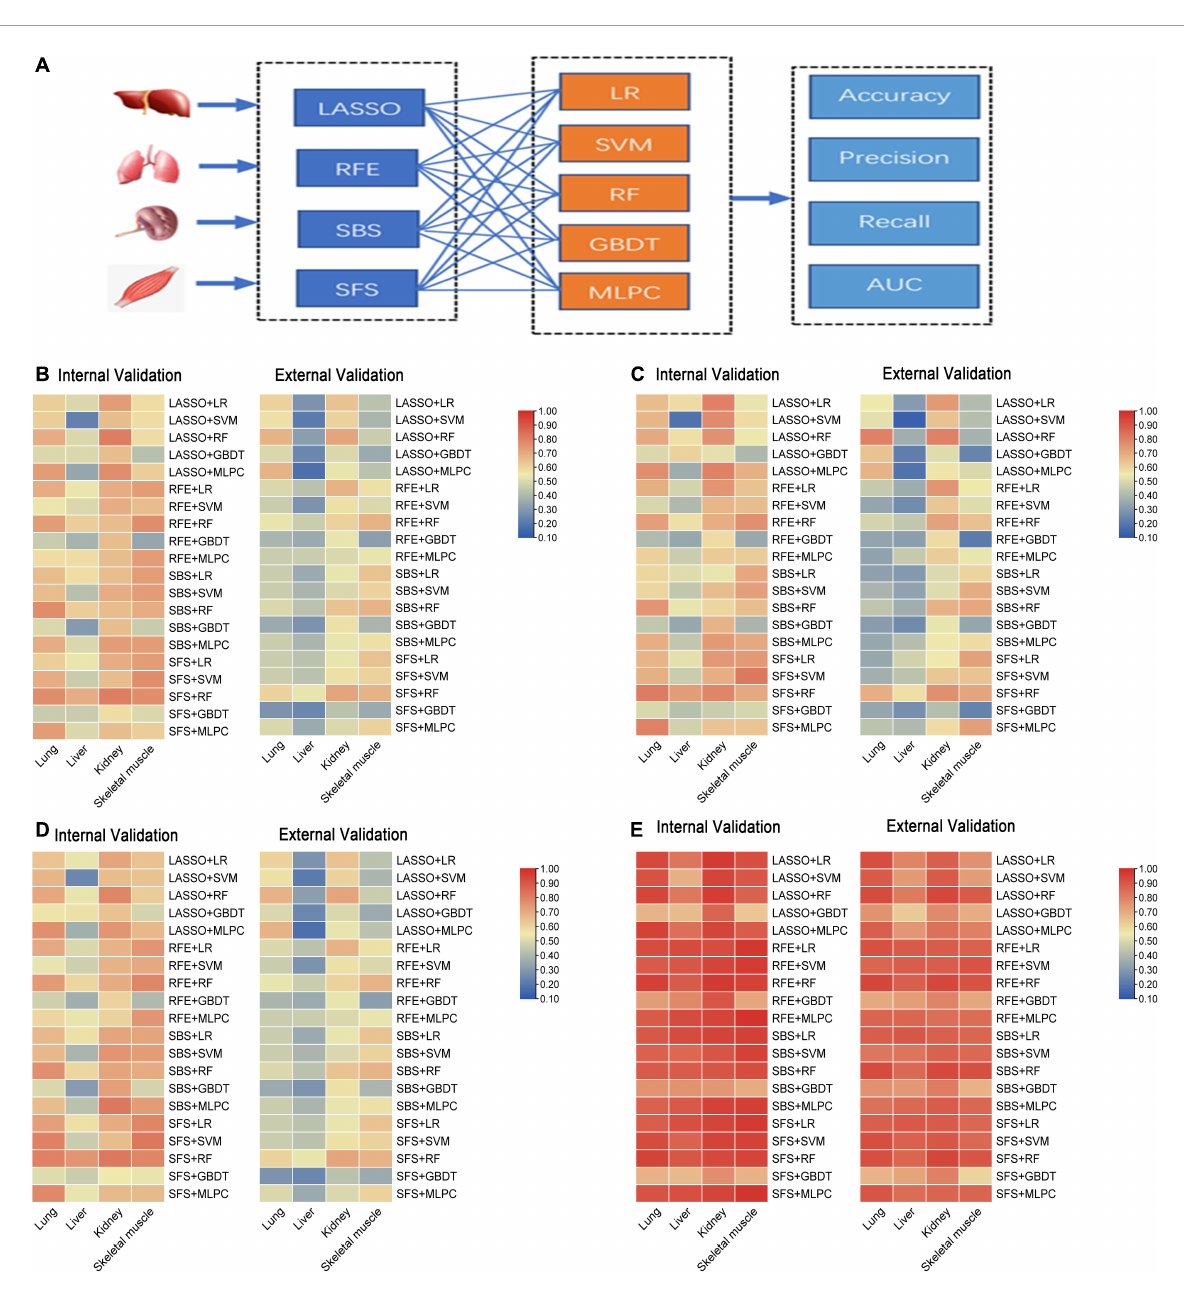
FIGURE4 The performance of sub-models generated by cross-combination of four feature selection methods and five machine learning algorithms based on single organ. (A) Workflow of cross-combination of four feature selection methods and five machine learning algorithms to establish sub-models to predict PMI based on the lung, liver, kidney, and skeletal muscle. (B) The heat map on the left show accuracy of internal validation of sub-models based on lung, liver, kidney and skeletal muscle, and the heat map on the right shows the accuracy of external validation. (C) The heat map on the left show precision of internal validation of sub-models based on the lung, liver, kidney, and skeletal muscle, and the heat map on the right shows the precision of external validation. (D) The heat map on the left show recall of internal validation of sub-models based on the lung, liver, kidney, and skeletal muscle, and the heat map on the right shows the recall of external validation. (E) The heat map on the left shows AUC of internal validation of sub-models based on the lung, liver, kidney, and skeletal muscle, and the heat map on the right shows AUC of external